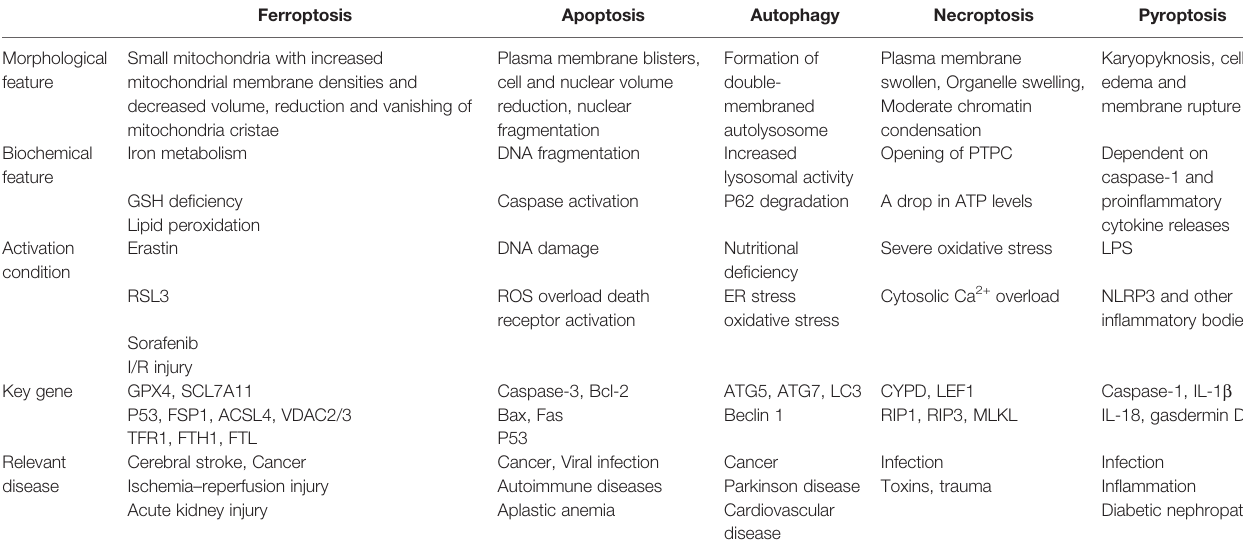
TABLE 1 | Features of different kinds of regulated cell